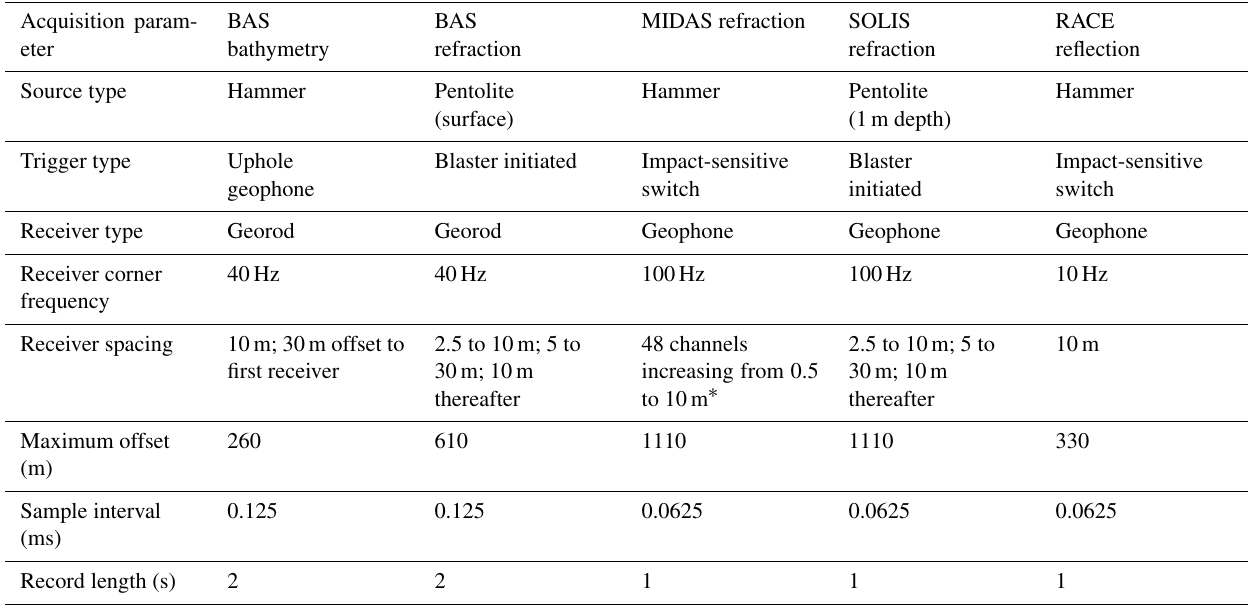
Table 1. Field acquisition parameters for new data presented here. Acquisition param-